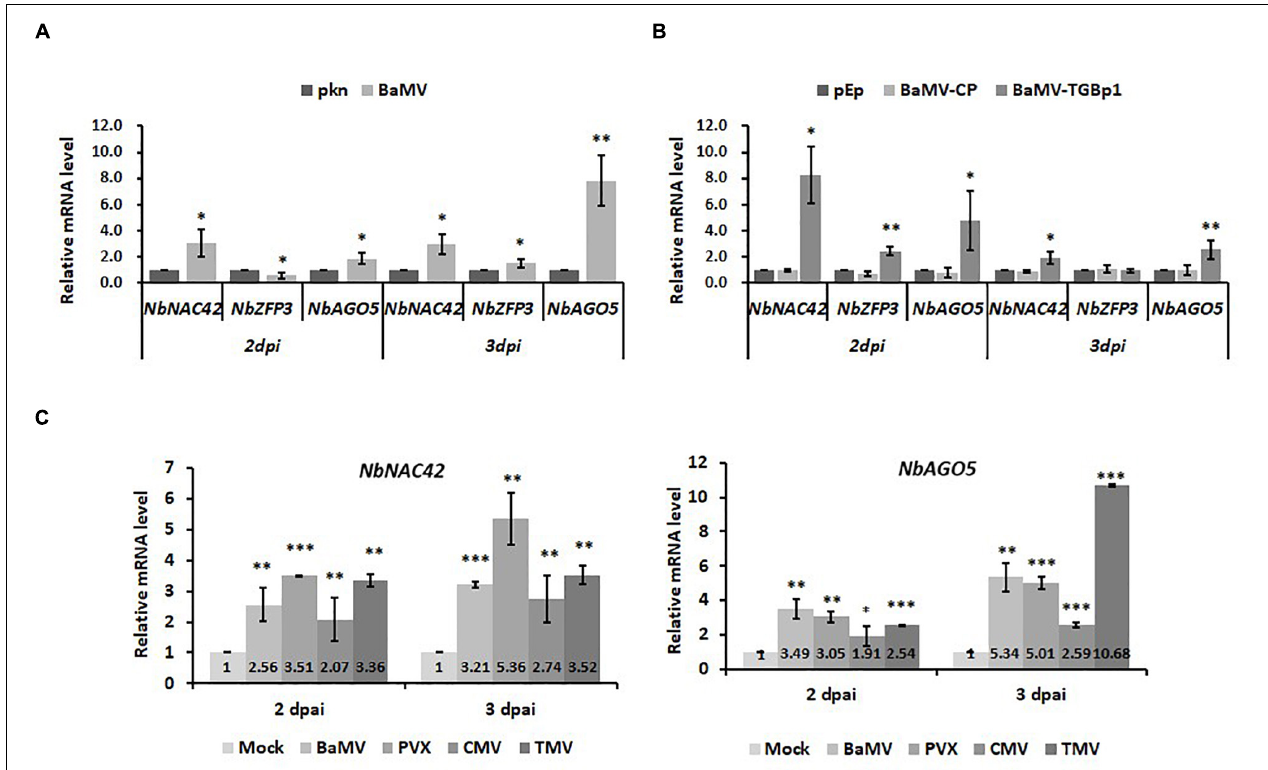
FIGURE 7 | Expression of NbNAC42 and NbZFP3 in response to challenges of various viruses in N. benthamiana . The expression level of NbAGO5 , NbNAC42, and NbZFP3 were analyzed by qRT-PCR in the plants infiltrated with A. tumefaciens harboring infectious construct of BaMV (A) , or expression vectors for BaMV-CP or BaMV-TGBp1 (B) . (C) The mRNA level of NbNAC42 and NbAGO5 were analyzed by qRT-PCR in the plants infiltrated with A. tumefaciens harboring infectious constructs of BaMV, PVX, CMV, and TMV at 2 and 3 dpi as compared to those in control groups. Relative mRNA accumulation levels of three genes were individually shown above; numbers the compared to controls (pkn or pEpyon). Data are means ± SE from at least three independent experiments. Statistical significance was analyzed using two-tailed student’s t -tests; * p < 0.05; ** p < 0.01; *** P <